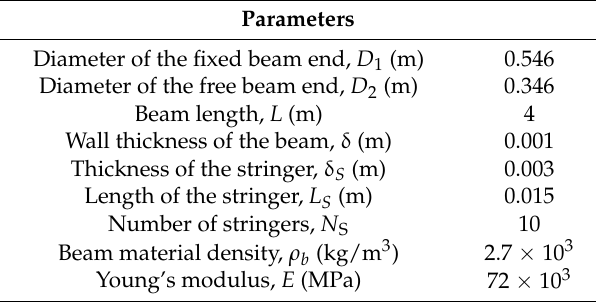
Table 2. Tail boom parameters.